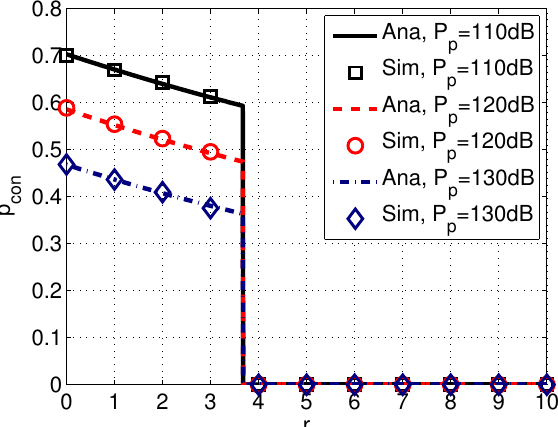
Figure 7. Probability of connection p con versus distance r with different transmission power of PUs P p . System parameters are set as k = 1, w = 10 m/s, λ p = 0.005, f = 30 kHz, P s = 100 dB, s = 1, δ s = 20 dB, and δ d = 20 dB.